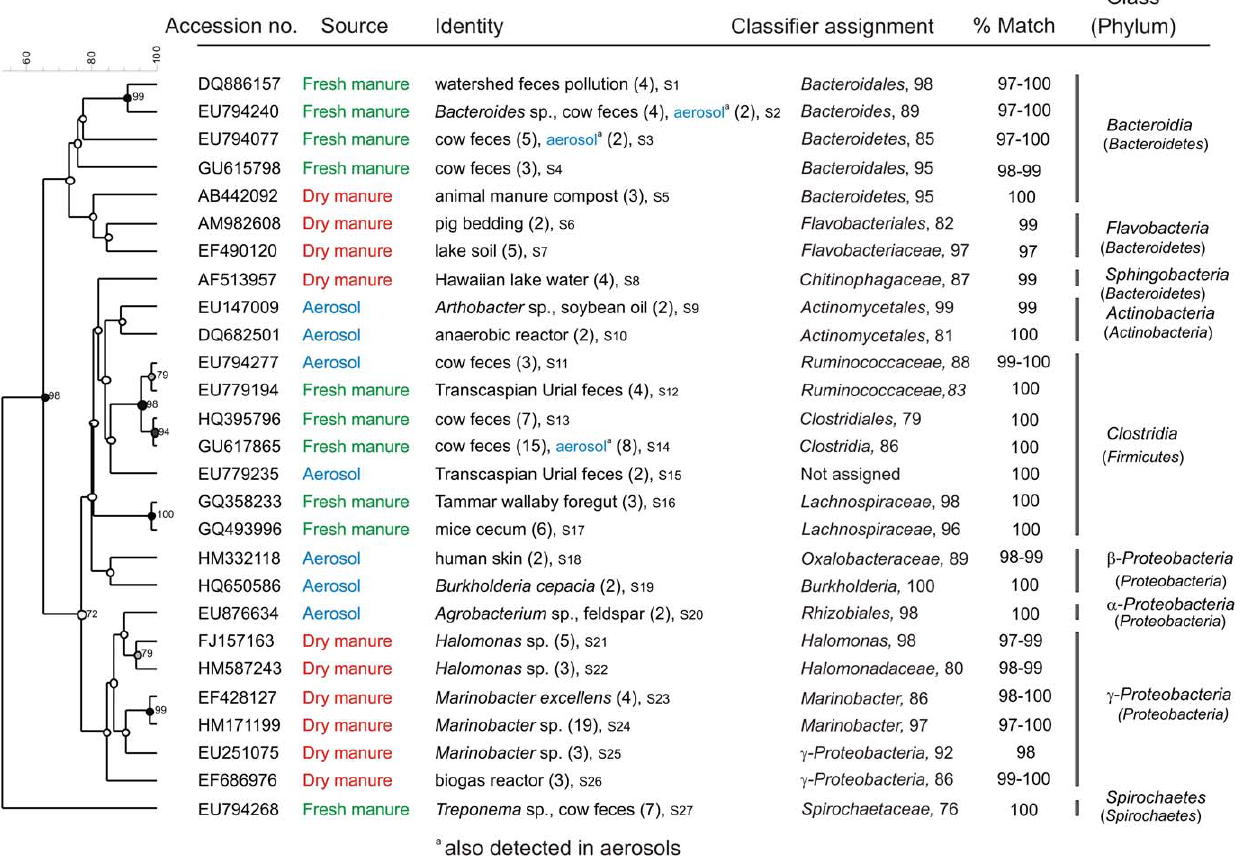
Figure 2. Phylogenetic relationship of 10 abundant 16S rRNA sequences from aerosol and manure samples from the Sonoma dairy. Identity or the original source of uncultured bacteria and the accession numbers are given. Numbers in parenthesis following the previous isolation source are number of clones characterized for the sequence. Numbers following the clones are identifiers for submissions to GenBank and sequence numbers S1 to S30 correspond with GenBank accession numbers HQ340004 to HQ340033. Bootstrap values . 70% are noted at each node. Numbers following the Classifier assignment to the hierarchial taxa are percent reliability values for the classification.